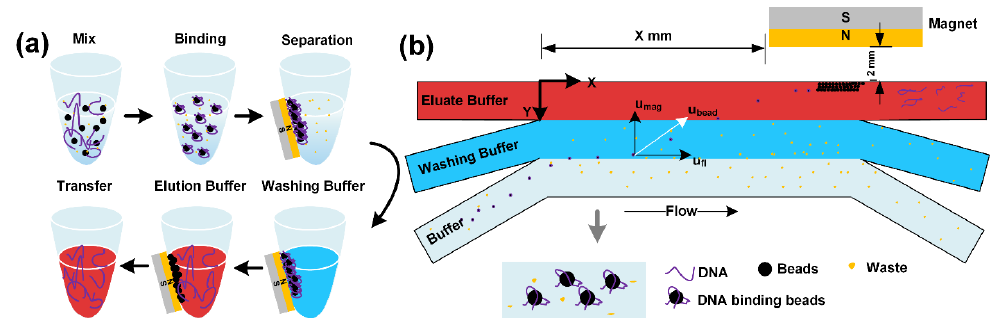
Figure 1. ( a ) Conventional magnetic beads purification of DNA in test tubes. Repeatedly resuspension and adsorption steps of beads are required for purification, leading to the time-consuming and boring experimental operation. ( b ) The schematic for continuous flow separation of magnetic beads to recover DNA via the deflection of DNA-carrying beads across laminar flow streams of washing and elution solutions.